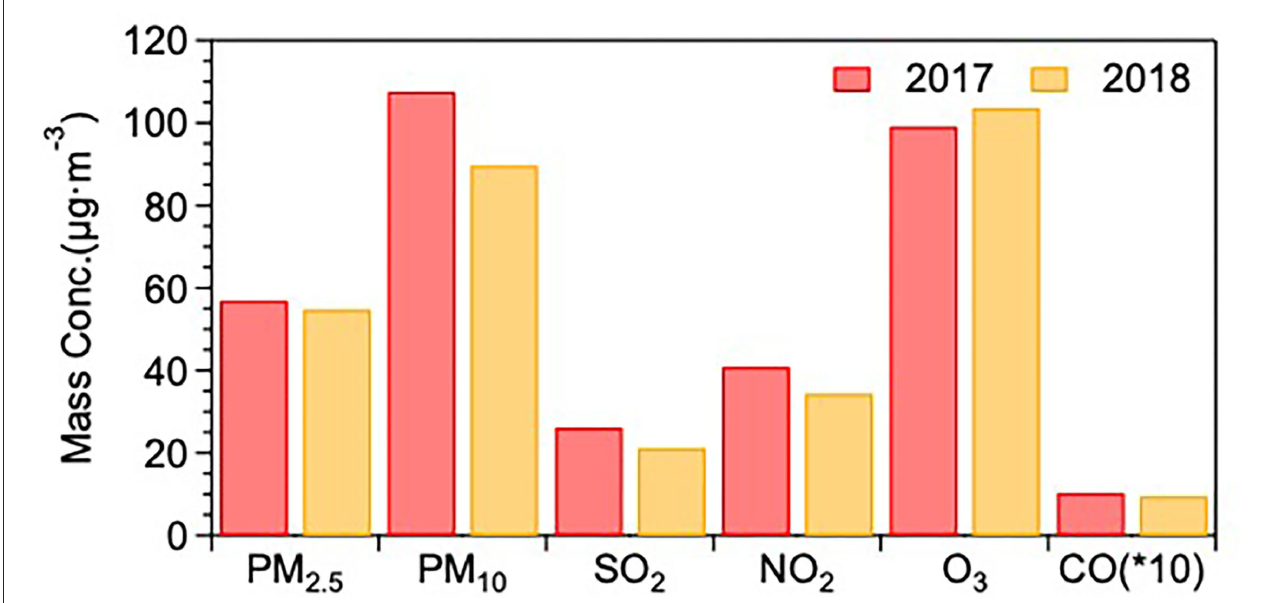
FIGURE2 The annual mean mass concentrations of six pollutants in Jining during 2017 and 2018 [the unit of CO is mg/m 3 , CO (*10) means the real CO mass concentration multiple 10].